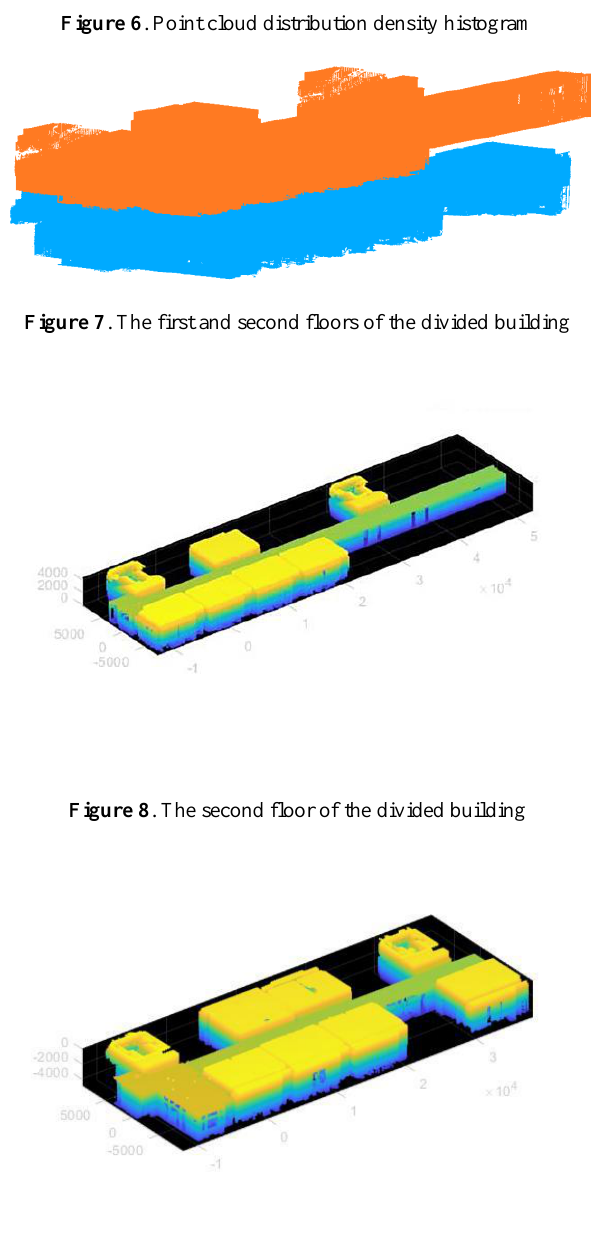
Figure 9 . The first floor of the divided building